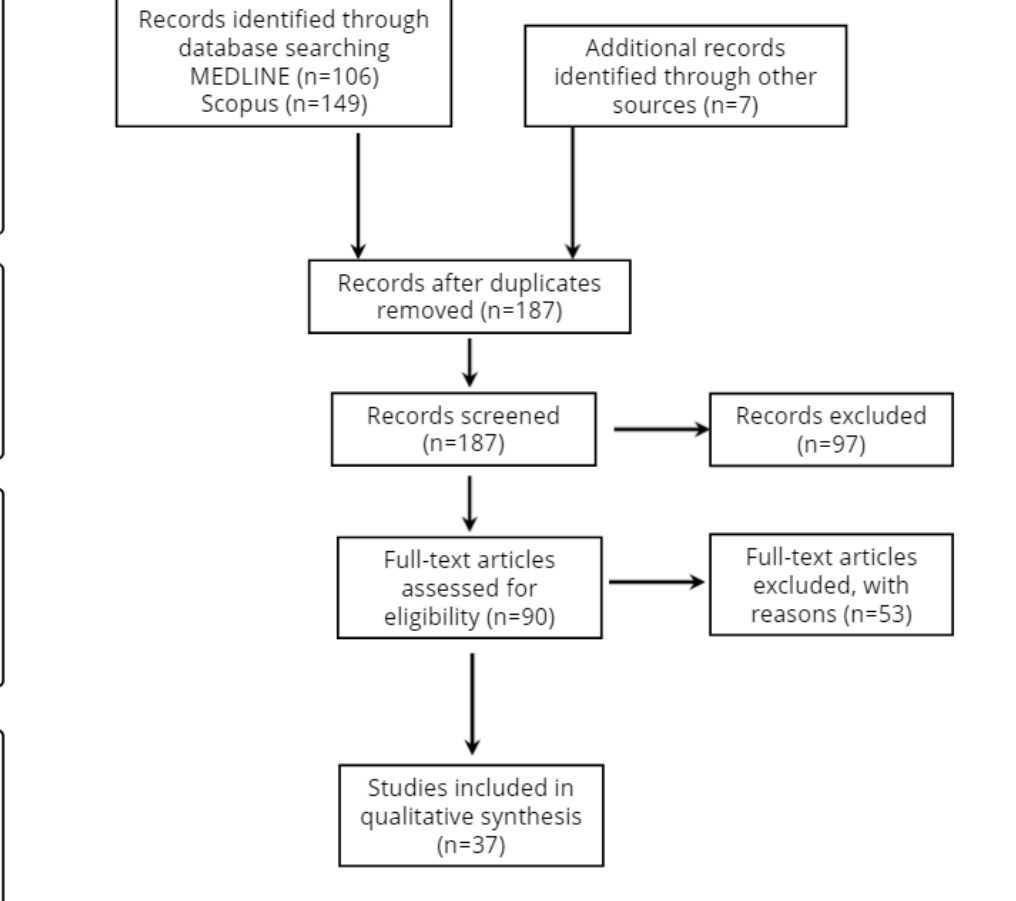
Figure 1. Study flow diagram (PRISMA flowchart).